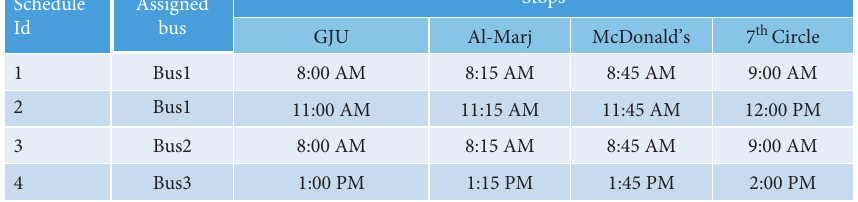
Figure 5: An example showing a bus route with its stops and schedules.